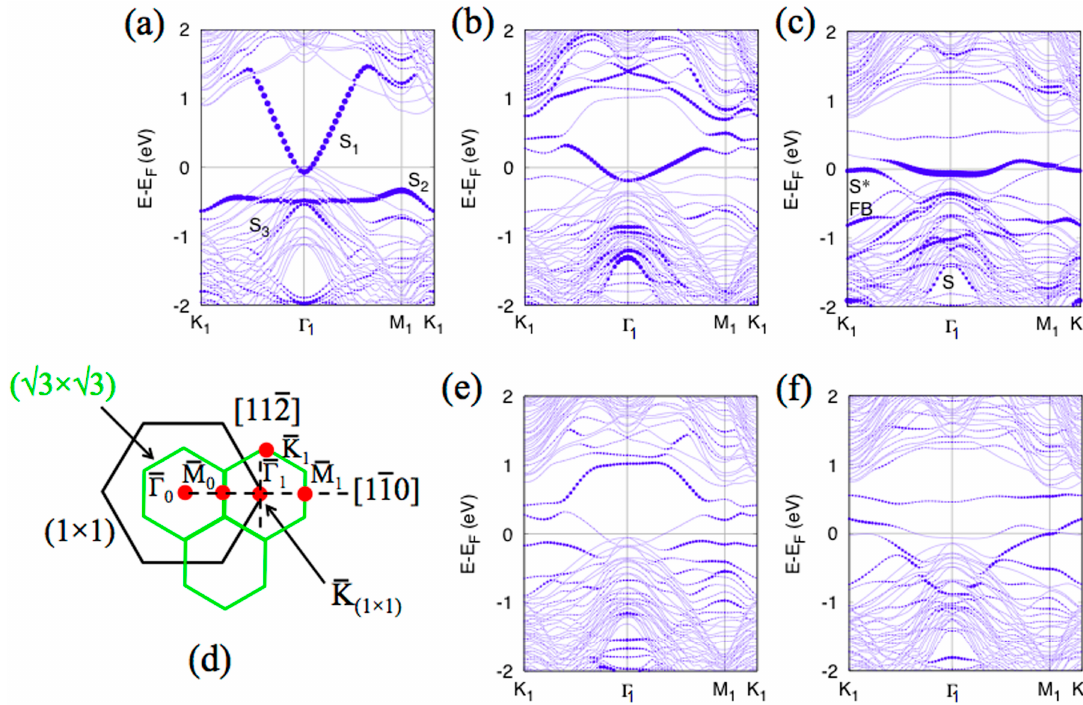
Figure 7. Second derivative band dispersion at RT from Si(111) √ 3 × √ 3 R30°–Ag (a); √ 3 × √ 3 of 4 MLs Si film grown at ~ 250 °C on Si(111) √ 3–Ag ( b ), and √ 3 × √ 3 Si film grown at ~ 200 °C on Si(111) √ 3 × √ 3–Ag (c). The origin of the wave vector is the 𝛤 1 point of the second Brillouin zone of the √ 3 × √ 3 SBZ at k = 1.09 Å − 1 along the [112] direction. The three surface states S 1 , S 2 , and S 3 belonging √ to the Si(111) 3–Ag interface are labeled, as well as S, S*, and FB from Si. The solid red line in ( a ), as well as the white dotted line in ( c ) are a guide for the eyes. Indeed, the dotted red curve is the best fit of the free-electron-like parabola of S 1 in ( b ), superimposed to S* in ( c ).